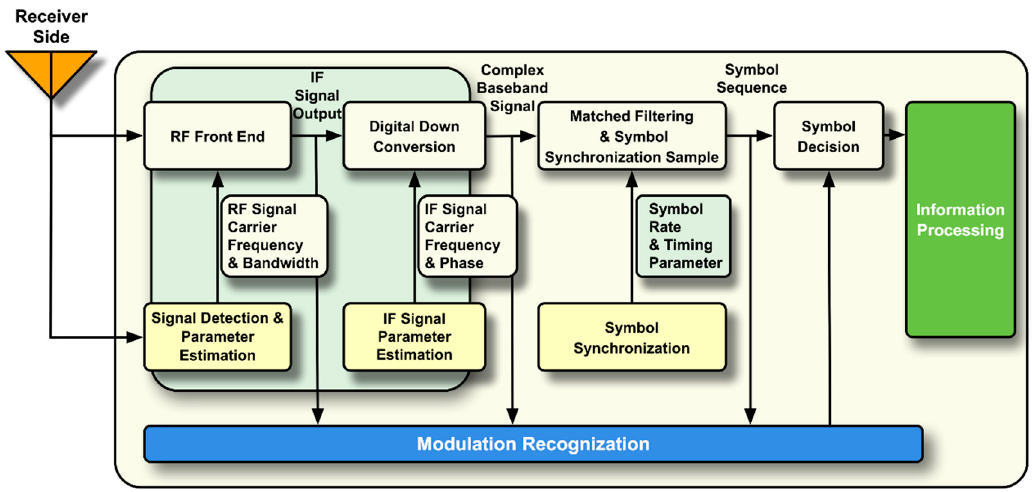
Figure 1. Recognition Signal Processing Flow.